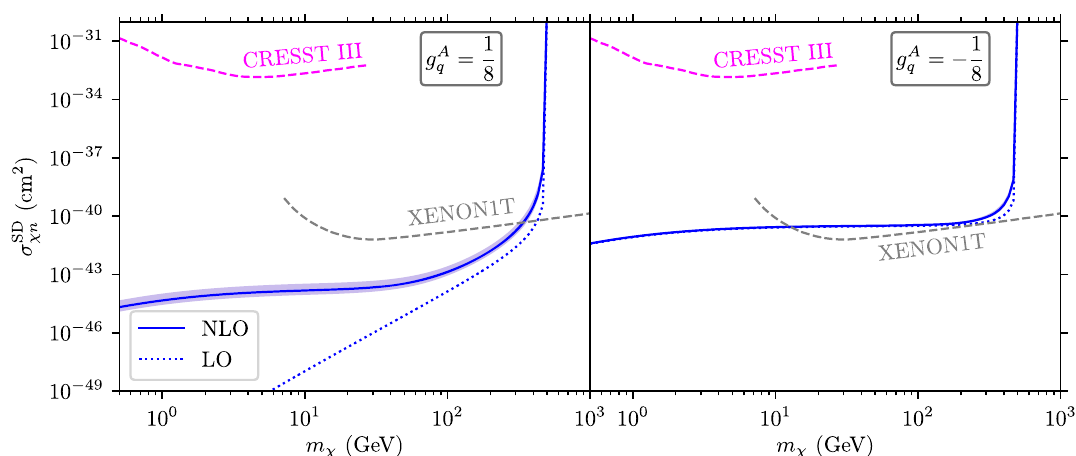
Fig. 10 Theoretical predictions at LO (dotted blue) and NLO (solid hatched blue area) for σ SD n together with bounds from CRESST and XENON for an s + t -channel model with g A q = 1 / 8 (left panel) and g A q = − 1 / 8 (right